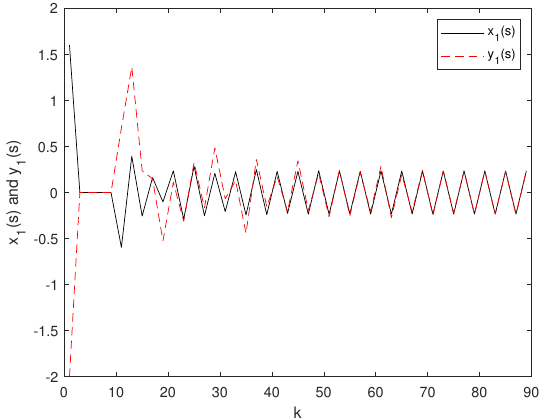
Figure 9. Trajectory curves of x 1 ( s ) and y 1 ( s ) with controller.